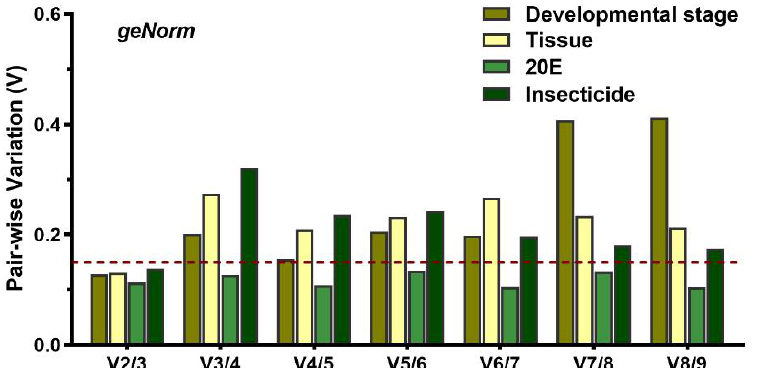
Figure 3. Determining the optimal number of reference genes for normalization by geNorm analysis. Average pair-wise variations (V n /V n+1 ) were calculated by geNorm between the normalization factors NF n and NF n+1 . A value above 0.15 indicates that an additional reference gene will significantly improve normalization.